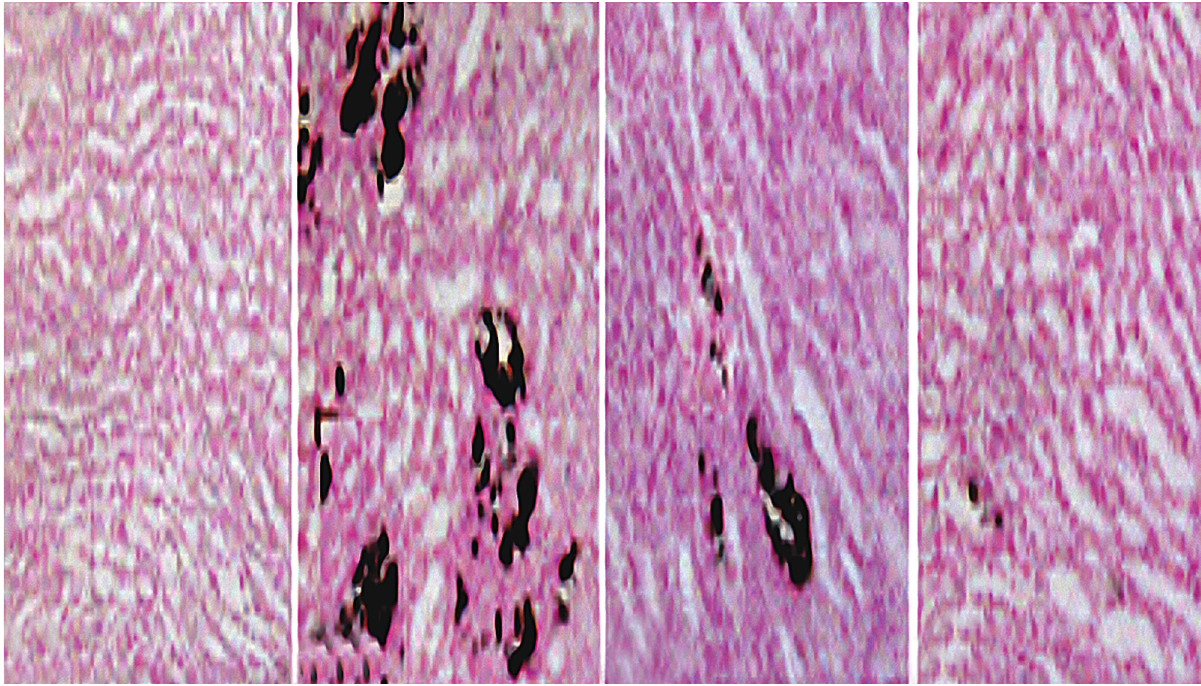
Figure 1 – Kidney crystallization generated by glyoxylate administration. A) Control mouse kidney. B) Kidney from a mouse treated with glyoxylate without herbal treatment where brown-stained calcium oxalate crystal retention in the distal tubules between the renal cortex and medulla can be seen. C) Kidney from a mouse received glyoxylate and 100 mg/Kg Rubus idaeus. D) Kidney from a mouse received glyoxylate and 200 mg/Kg Rubus idaeus. (X